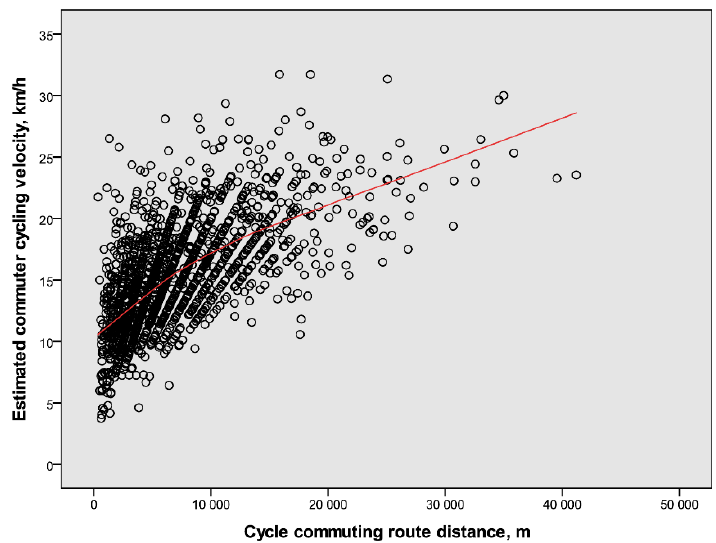
Figure 1. The relation between criterion-measured route distances and estimated velocities for commuter cyclists ( n = 1661, 34% males). The line fits 85% of the individual values.